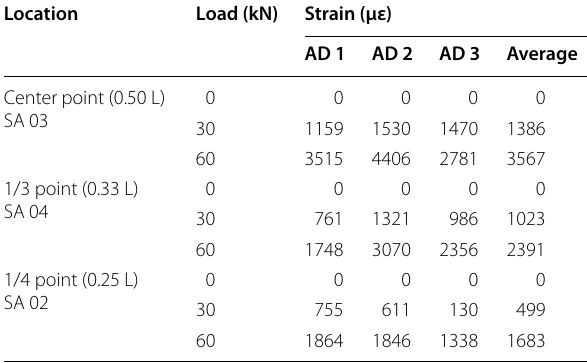
(0.25 L), 1/3 position (0.33 L), and center position (0.5 L)